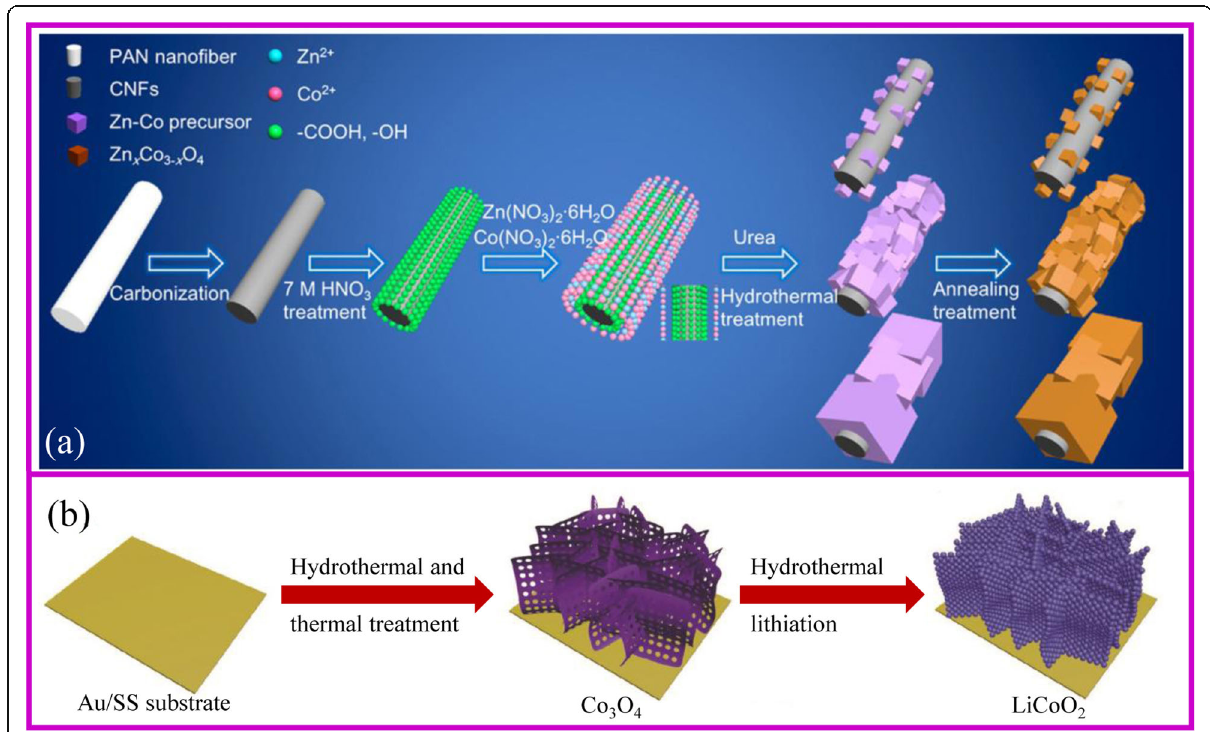
Fig. 3 a The scheme of ZnCoO x /CNF composite fabrication [47]. b The fabrication of cathode electrode using hydrothermal method